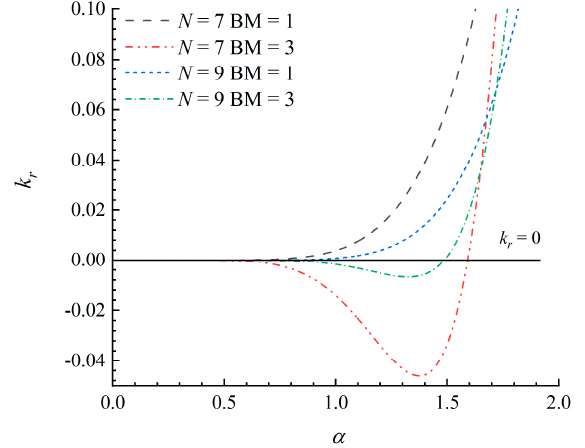
Figure 7. Comparison of dissipation coefficients of N = 7 and N = 9 schemes.